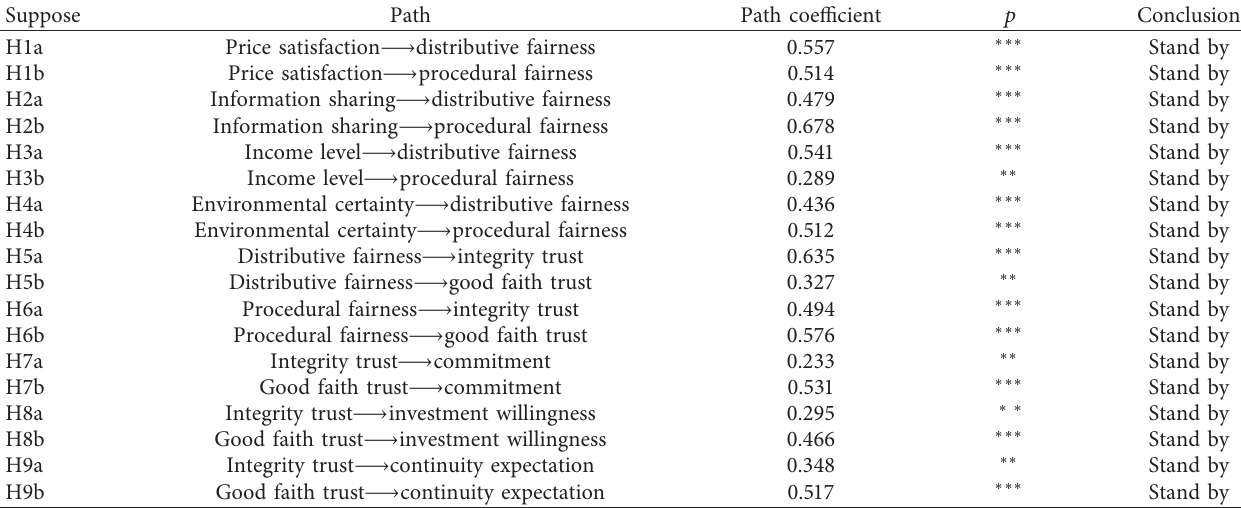
Table 4: Hypothesis verification